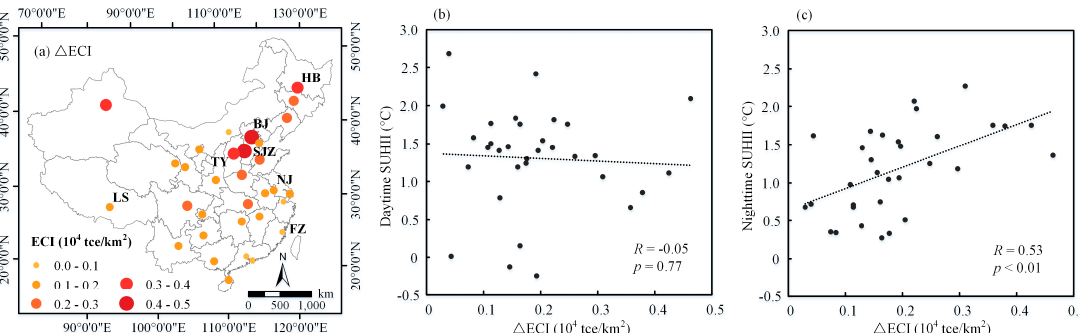
Figure 6. ( a ) The spatial distribution of the urban-suburban difference in the annual mean energy consumption intensity ( Δ ECI), averaged over the period of 2008–2012 for the 32 major cities in mainland China, and the scatterplots of Δ ECI versus the annual mean of the ( b ) daytime surface urban heat island intensity (SUHII) and ( c ) nighttime SUHII. R represents the correlation coefficient value, and p < 0.01 represents a significant correlation at the 99% confidence level.